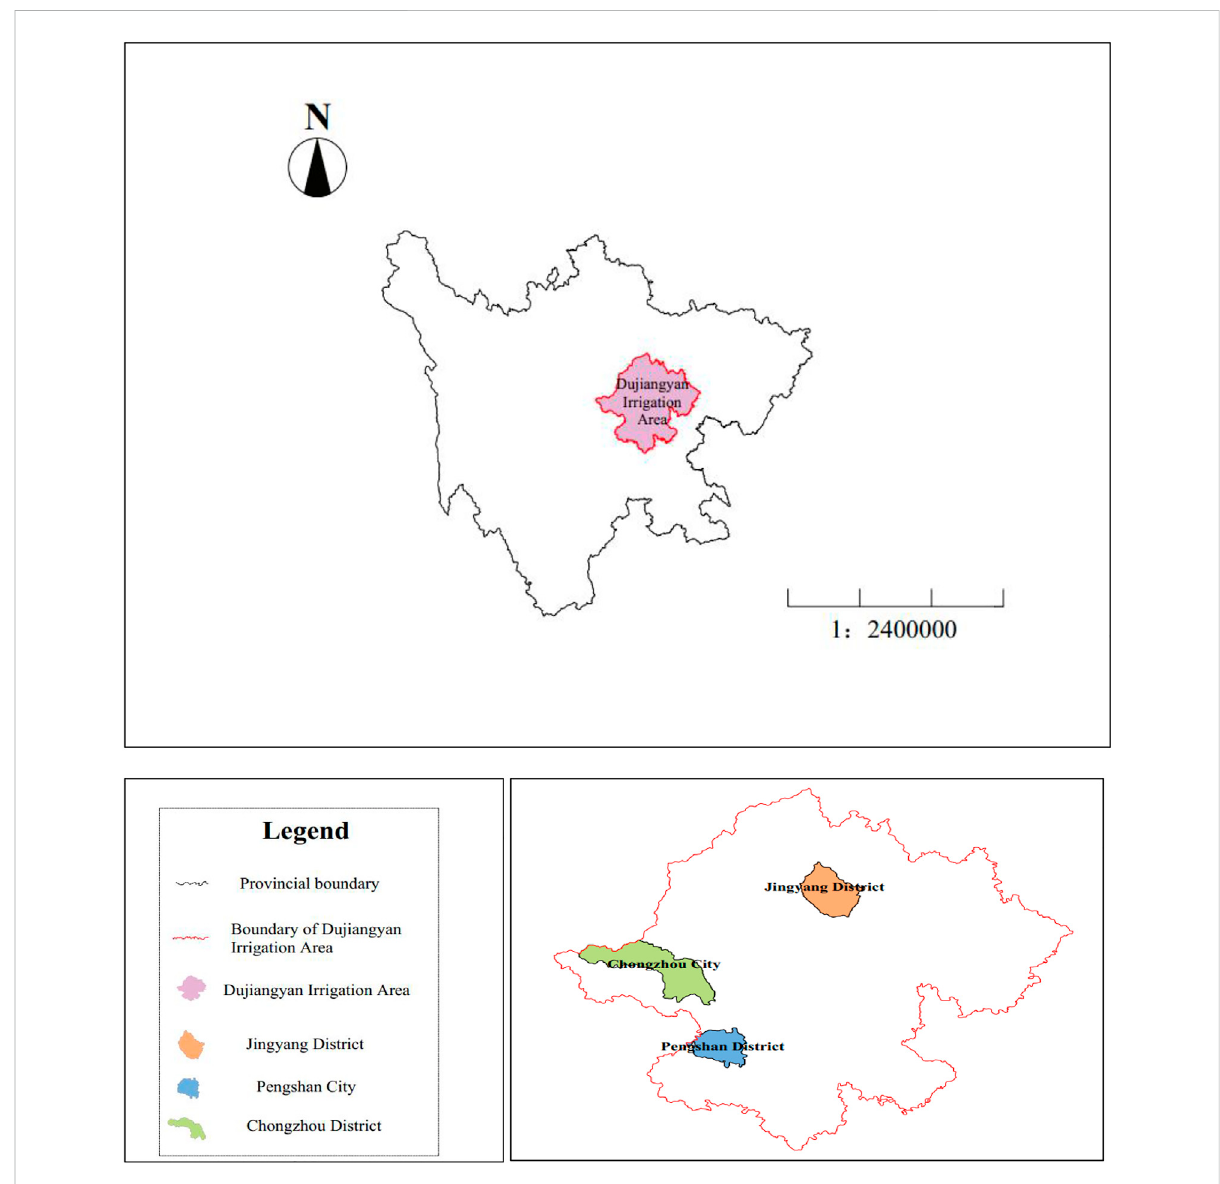
FIGURE 4 Dujiangyan Irrigation Area in Sichuan Province and the three selected study